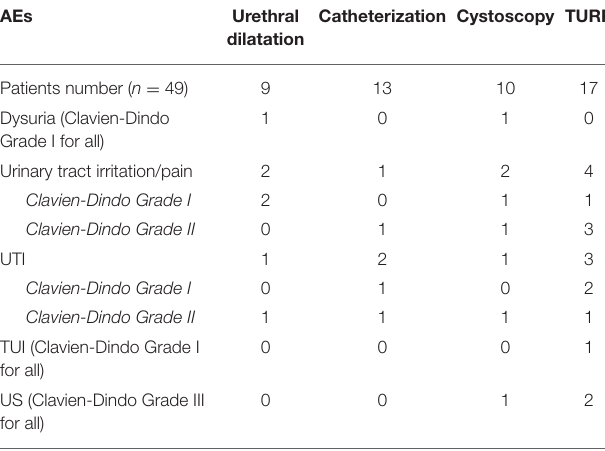
TABLE 3 | Treatment-related adverse events. AEs Urethral Catheterization Cystoscopy TURP dilatation Patients number ( n =